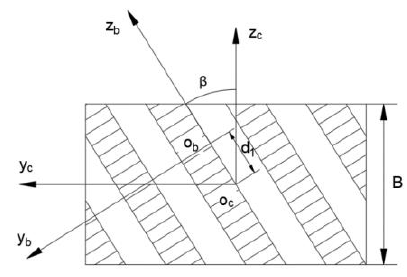
Figure 6. Rack projection.